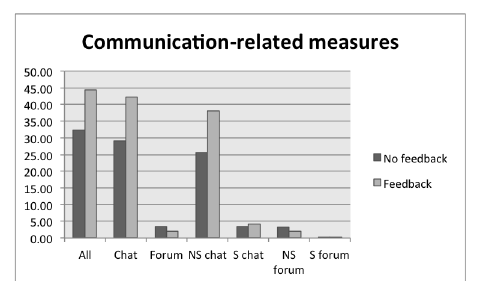
Figure 4. Comparison of Feedback and No-Feedback teams on Communication-related